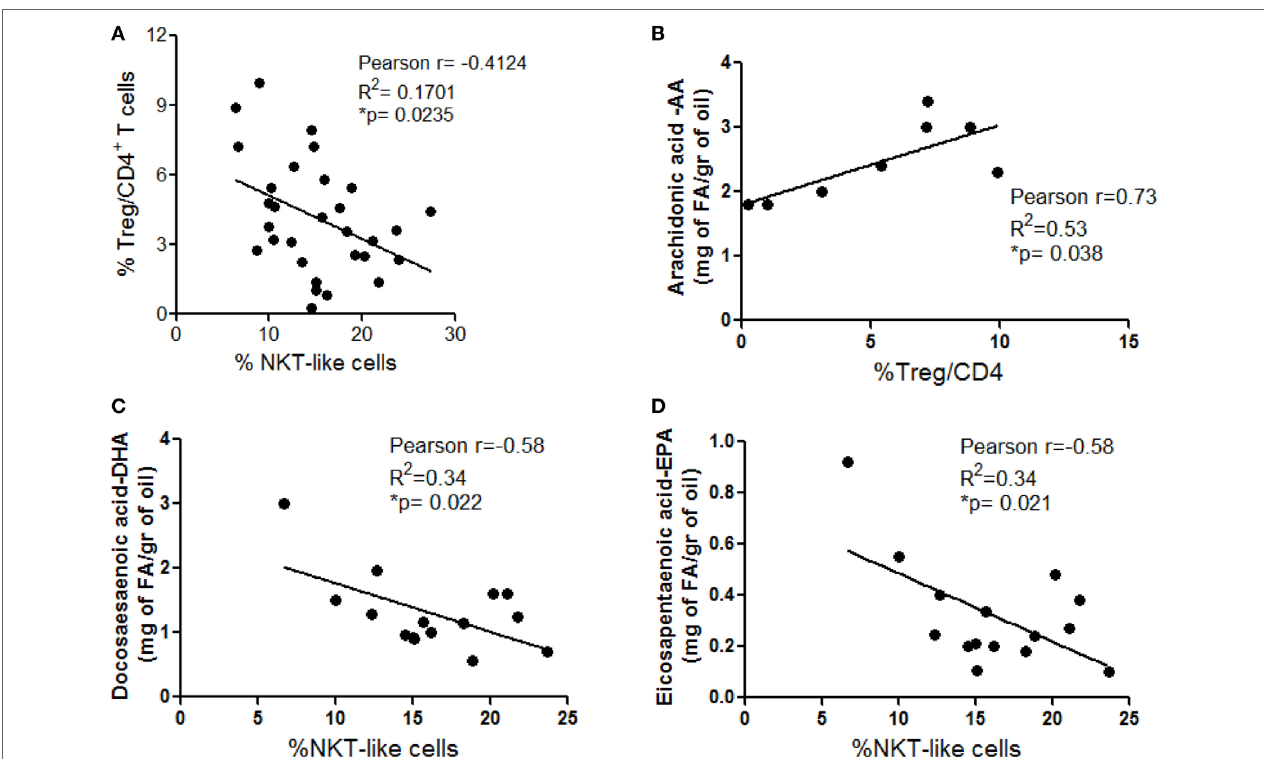
FigUre 6 | Inverse distribution between total visceral adipose tissue (VAT) stromal vascular fraction (SVF) regulatory T (T reg ) and NKT-like cells and correlation with VAT polyunsaturated fatty acid content. Pearson’s correlation between: total T reg and NKT-like cell frequencies in VAT SVF (a) , arachidonic acid (AA) content, evaluated in visceral adipocytes, and T reg cell frequency estimated in VAT SVF isolated from lean normal weight (Nw) and obese (Ob) donors (B) , and docosahexaenoic (DHA) (c) and eicosapentaenoic acid (EPA) (D) content, evaluated in visceral adipocytes, and NKT cell frequency estimated in VAT SVF isolated from lean (Nw), lean affected by colorectal cancer (CRC) (Nw/CC) and Ob affected by CRC (Ob/CC)